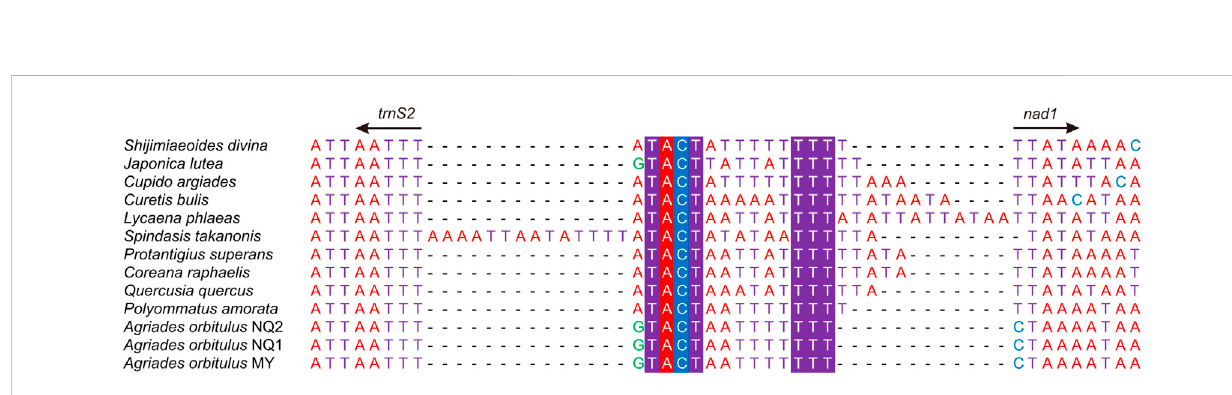
FIGURE 9 Non-coding region between trnS2 and nad1 in the 13 Lycaenidae mitogenomes. Conserved bases in the 13 Lycaenidae are